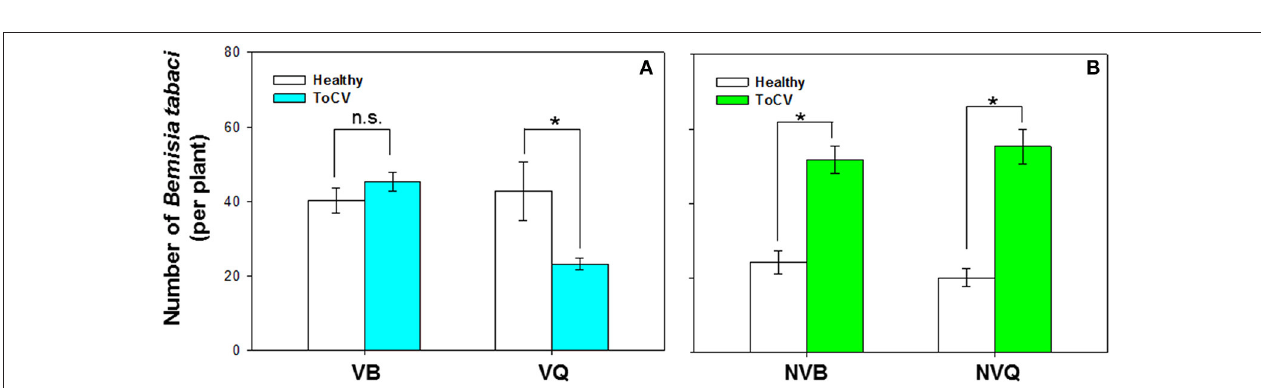
FIGURE 5 | Preference of B. tabaci MEAM1 and MED for tomato chlorosis virus -infected vs. healthy tomato plants. (A) Preference of viruliferous MEAM1 and MED. (B) Preference of non-viruliferous MEAM1 and MED. VB, viruliferous MEAM1; VQ, viruliferous MED. NVB, non-viruliferous MEAM1; NVQ, non-viruliferous MED. Values are means ± SE. For each group of two means, an asterisk indicates a significant difference between the numbers on infected vs. healthy tomato plants ( P < 0.05; N =